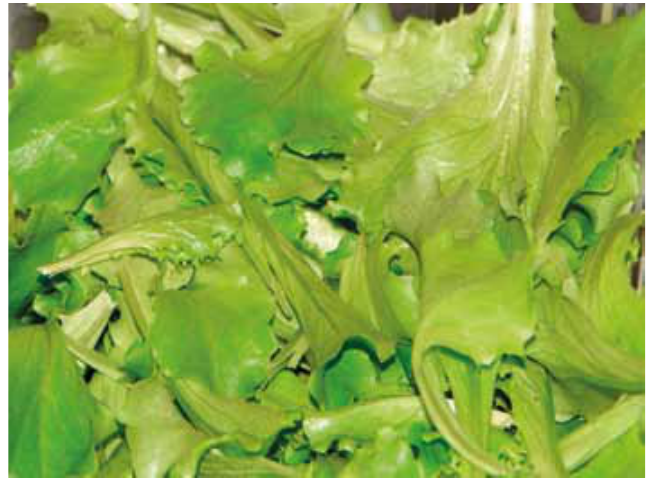
Fig. 4 - Lettuce treated with ozone after 3 days of storage at 4°C.